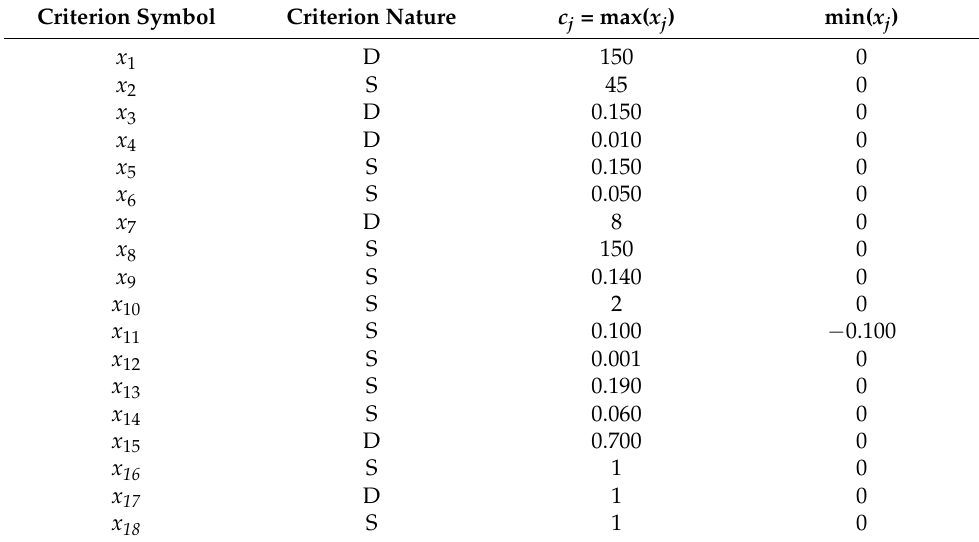
Table 2. The values c j , max( x j ), and min( x j ) adopted for the individual variables for the purpose of converting them from destimulants to stimulants and normalising the values. Criterion Symbol Criterion